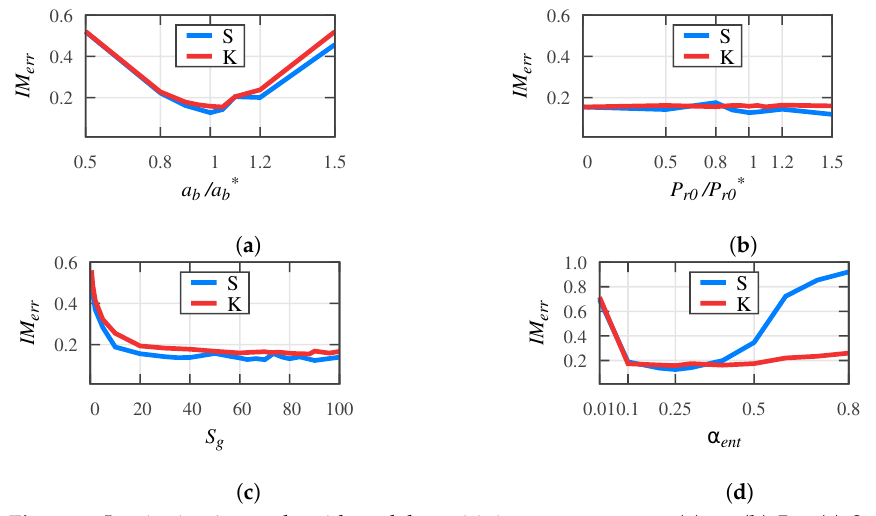
Figure 6. Impinging jet—sub-grid model sensitivity to parameters: ( a ) a b . ( b ) P r 0 . ( c ) S g . ( d ) α ent . Both entrainment formulations present similar results. Concerning a b , IM err < 0.2 if the variation is inferior to ± 20%. However, a shift of ± 50% conducts to an unsatisfactory IM err ≈